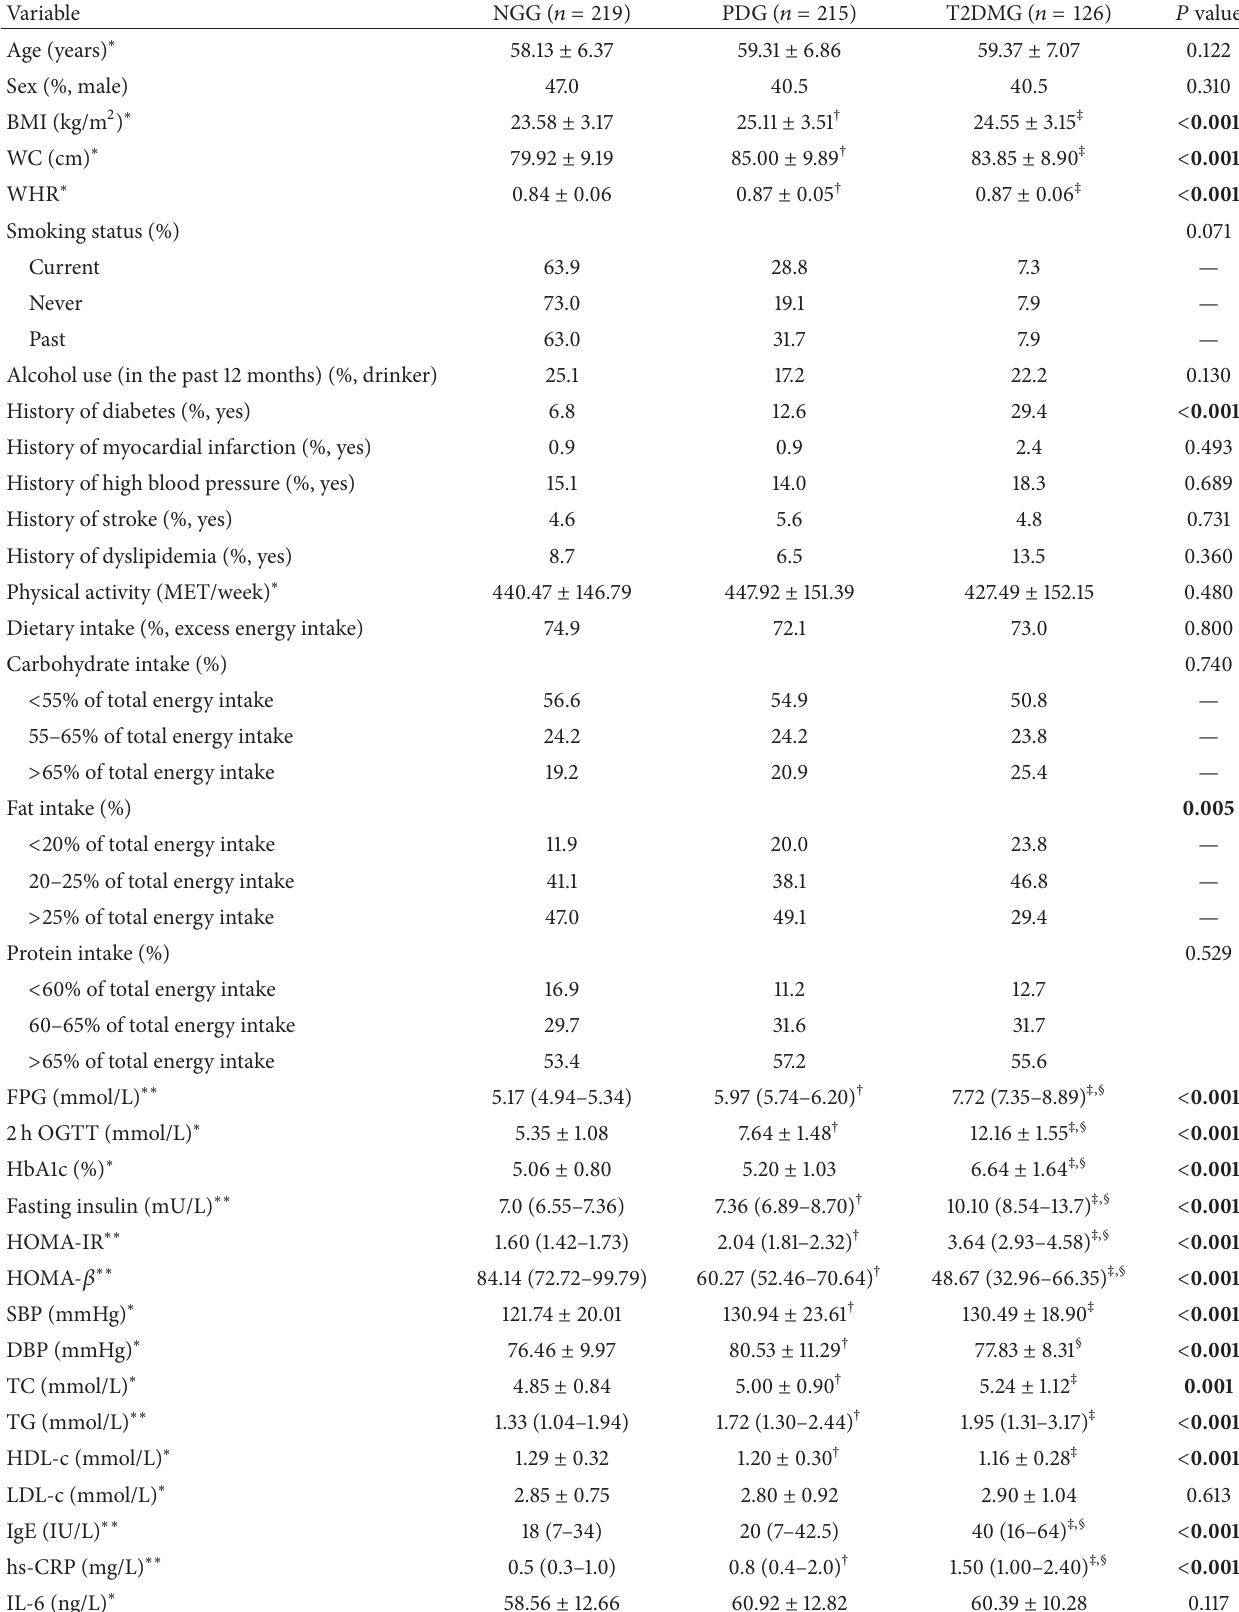
Table 1: Baseline characteristics of 560 subjects with different glucose status grouped according to fasting, postload glucose levels, and